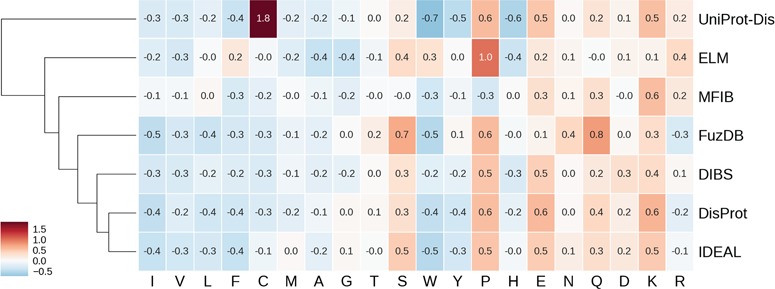
Hierarchically clustered heat map of amino acid enrichment. Clustering is based on Euclidean distance between frequency vectors. Each value represents the fold increase (red) or decrease (blue) compared to the TrEMBL amino acid distribution.